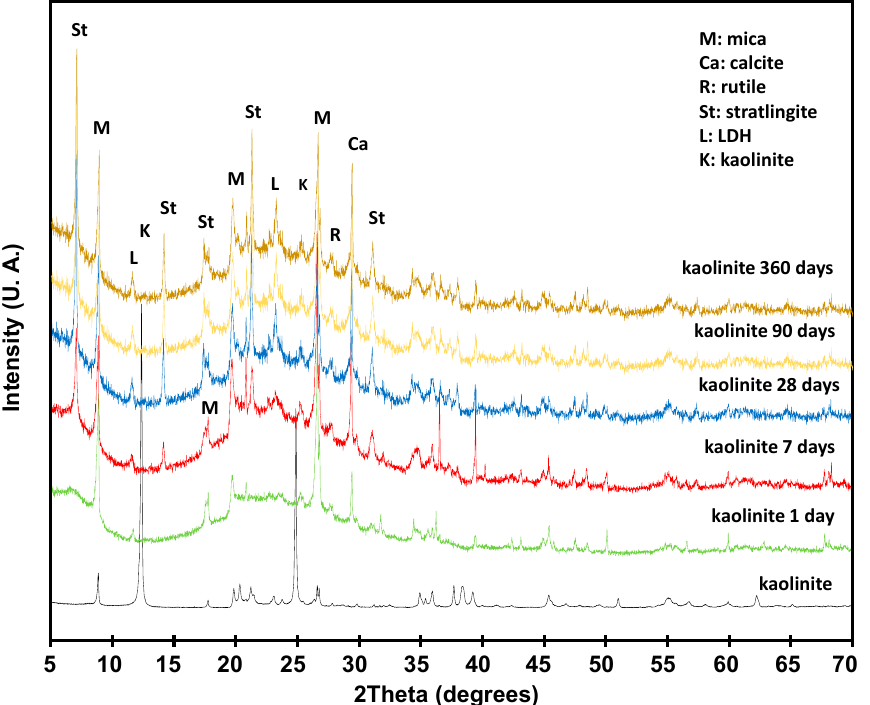
Figure 4. XRD patterns from kaolin / lime systems at one, seven, 28, 90, and 360 days of pozzolan reaction at 750 °C /2 h.